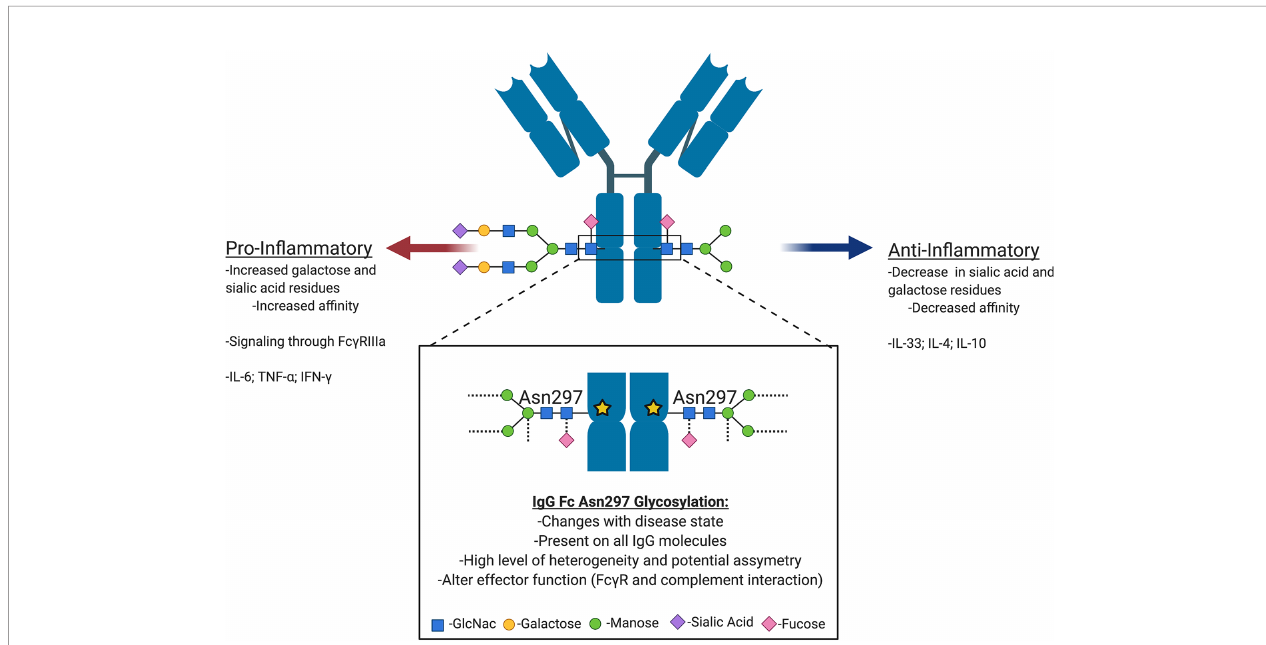
FIGURE 4 | Antibody N-glycosylation can in fl uence antibody effector functions. Antibodies are asymmetrically glycosylated on a conserved Asn297 residue within each of their Fc fragments. There are estimated to be at least 33 different glycosylation signatures that can be post-translationally added to an antibody. The fact that each antibody can be asymmetrically glycosylated on each Fc fragment suggests that there are many iterations of glycan modi fi cations. Antigen-Antibody complexes can thus stimulate pro- or anti-in fl ammatory responses based on the combination of glycans